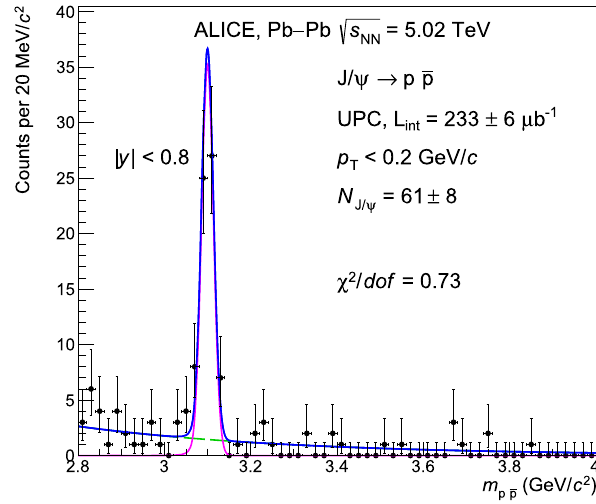
Fig. 2 Left: Invariant mass distribution of pp pairs. The dashed green line corresponds to the background description. The solid magenta and red lines correspond to Crystal Ball functions representing the J /ψ and ψ (cid:2) signals, respectively. The solid blue line corresponds to the sum of